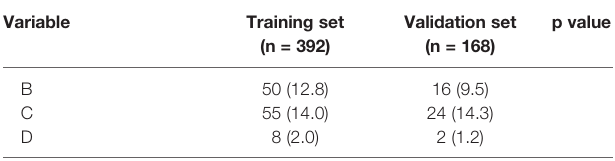
TABLE 1 | Baseline demographics and clinical characteristics of patients in training cohort and validation